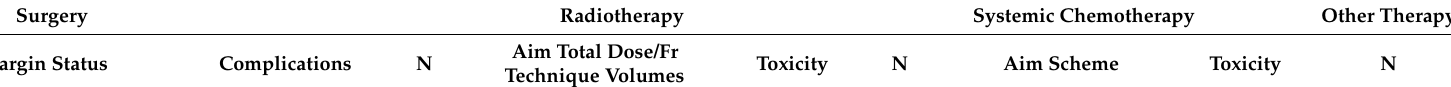
Table 2. Overview of treatment